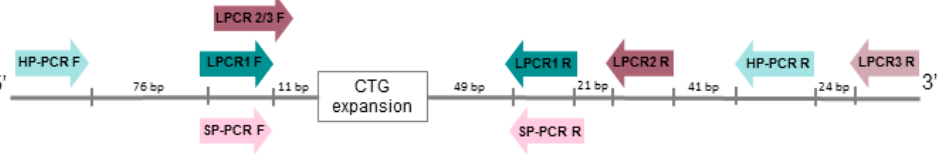
Figure 1. DMPK gene and location of the primer sets. Primers sets are indicated by the name of the technique and identified with a different background color. All of them were located outside the CTG expansion. LPCR2 and LPCR3 share the same forward primer. The distance (bp) between primers is also indicated. Abbreviations: F—forward; HPE-PCR—heat pulse extension-polymerase chain reaction; LPCR—long polymerase chain reaction; R—reverse; SP-PCR—small pool polymerase chain reaction.